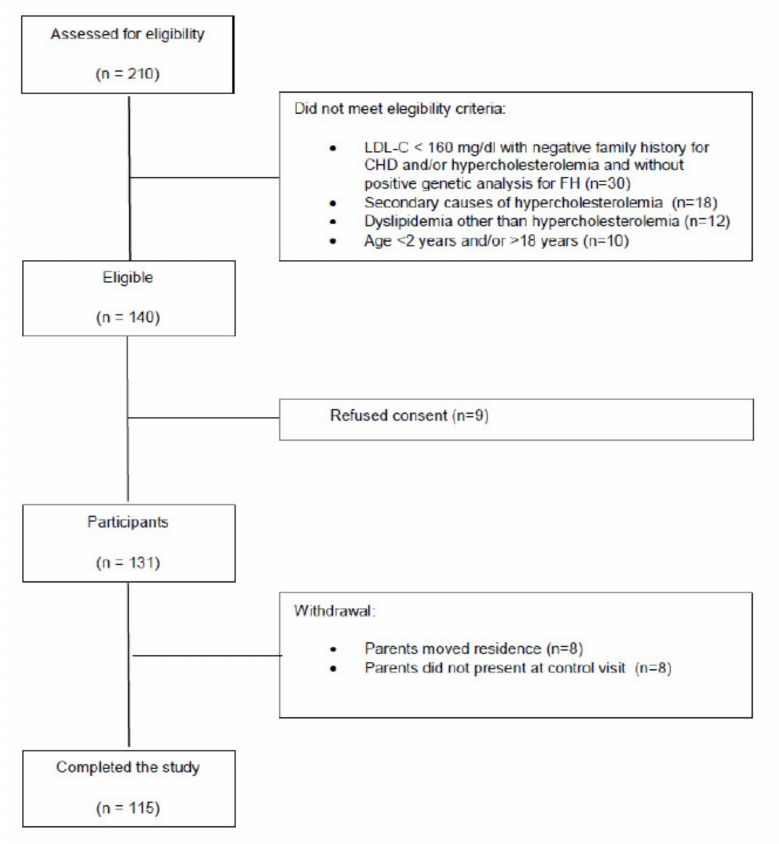
Figure 1. Progression of patients through the